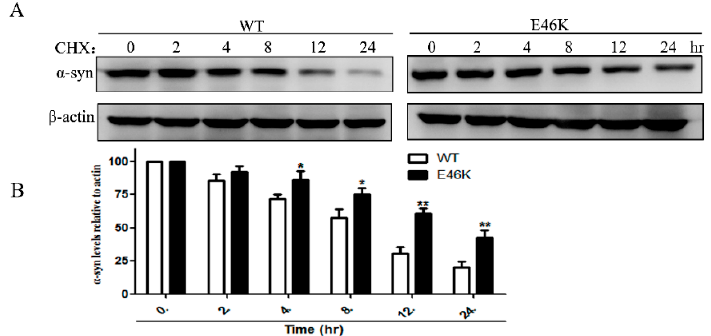
Figure 4. E46K mutant α -syn turned over more slowly when compared with WT α -syn. ( A ) PC12 cells stably overexpressing WT and E46K mutant α -syn were treated with 10 mg/mL CHX for the indicated periods of time and α -syn levels were measured by Western blotting. ( B ) Representative blots of three independent experiments were shown. β -Actin levels demonstrated equal loading. Data were expressed as means ± SD for three independent experiments performed in triplicate. * p < 0.05, ** p < 0.01 when compared with the WT